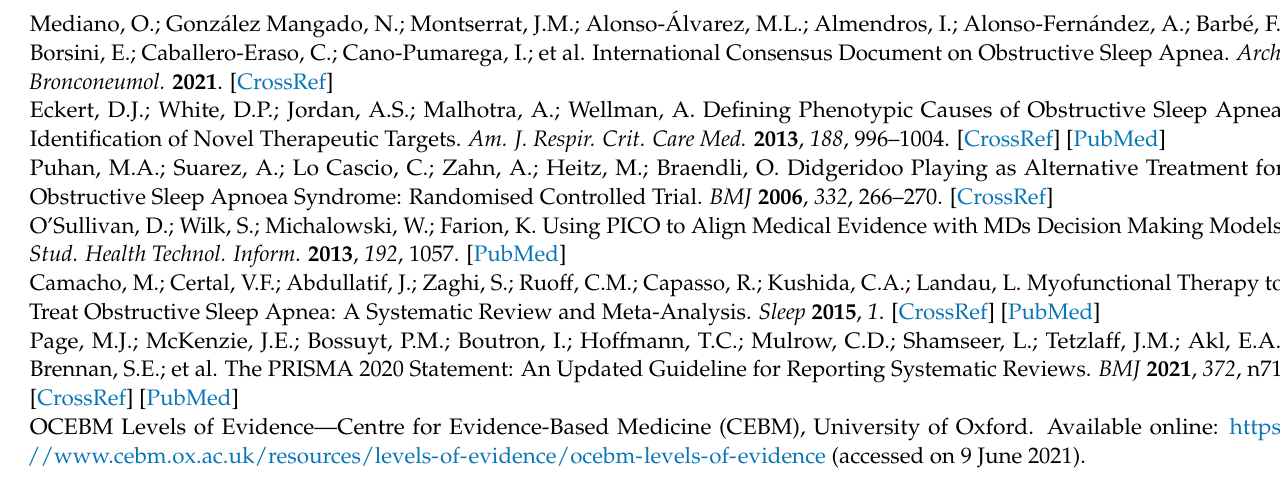
Table S3: Myofunctional therapy